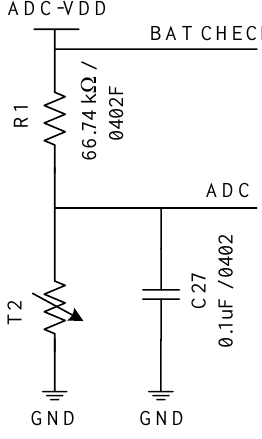
Figure 9. Temperature conversion circuit.